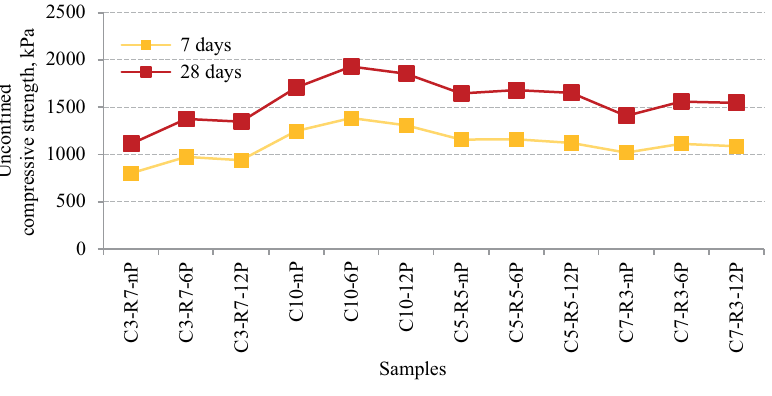
Figure 3. The unconfined compressive strength of samples containing 10% stabiliser and RHA/OPC ratios of 0:10, 3:7, 5:5 and 7:3